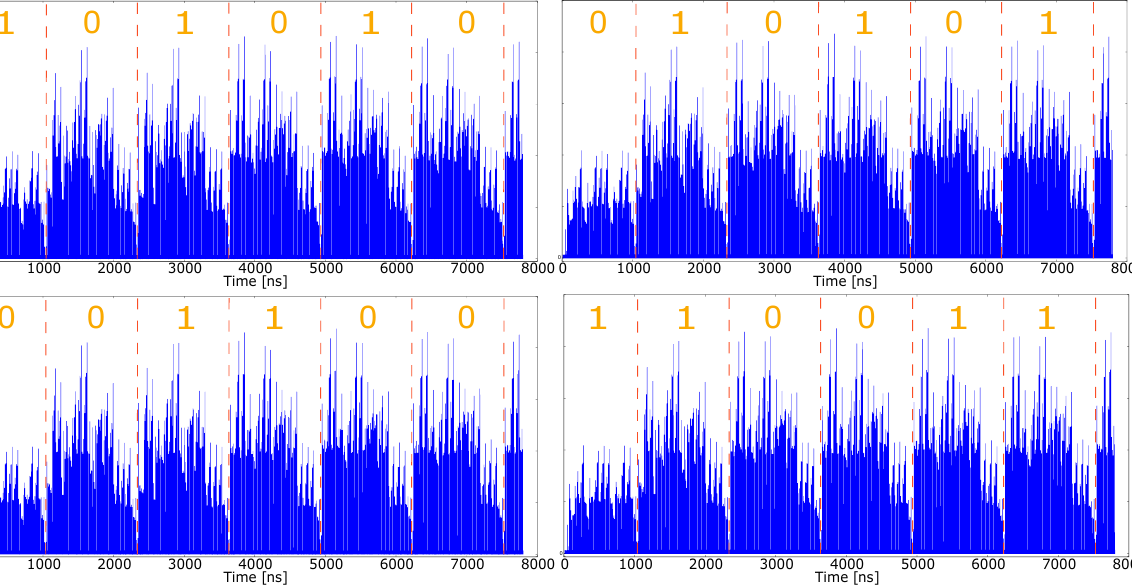
Figure 9. Acquired Power Traces for the Modified Double-and-Add-Always (Algorithm 3) where the least significant part of the key k is (LSB first): -101010 ( top left ), -010101 ( top right ), -001100 ( bottom left ), -110011 ( bottom right